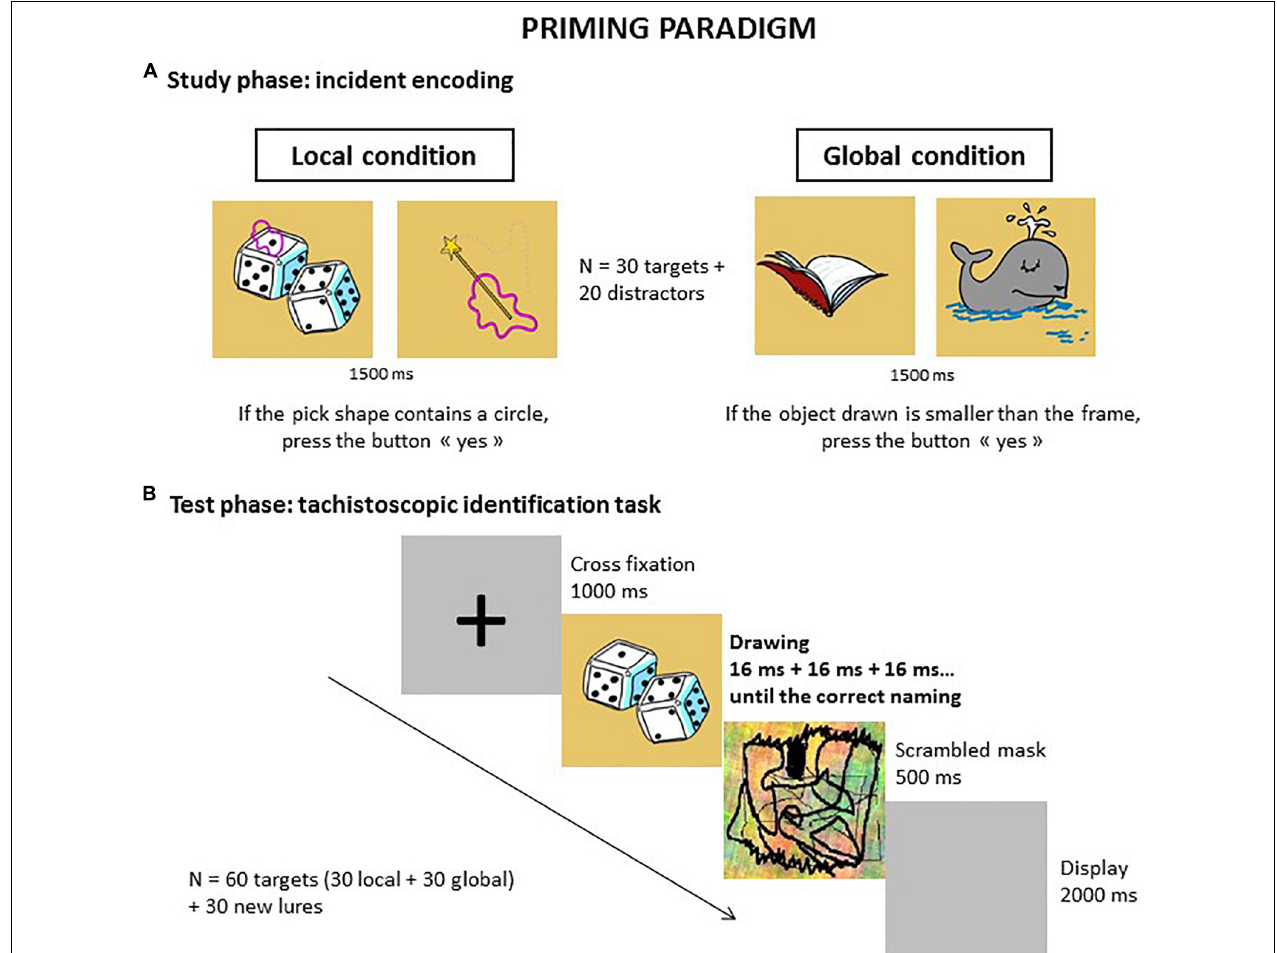
FIGURE 1 | Priming paradigm. The task included a study phase with both local and global conditions provided in a counterbalanced order between subjects (A) , followed after a 10 min delay by a test phase (B) which consisted in identifying all studied drawings presented with an initial 16 ms time duration and increased with an incremental step of 16 ms up to correct